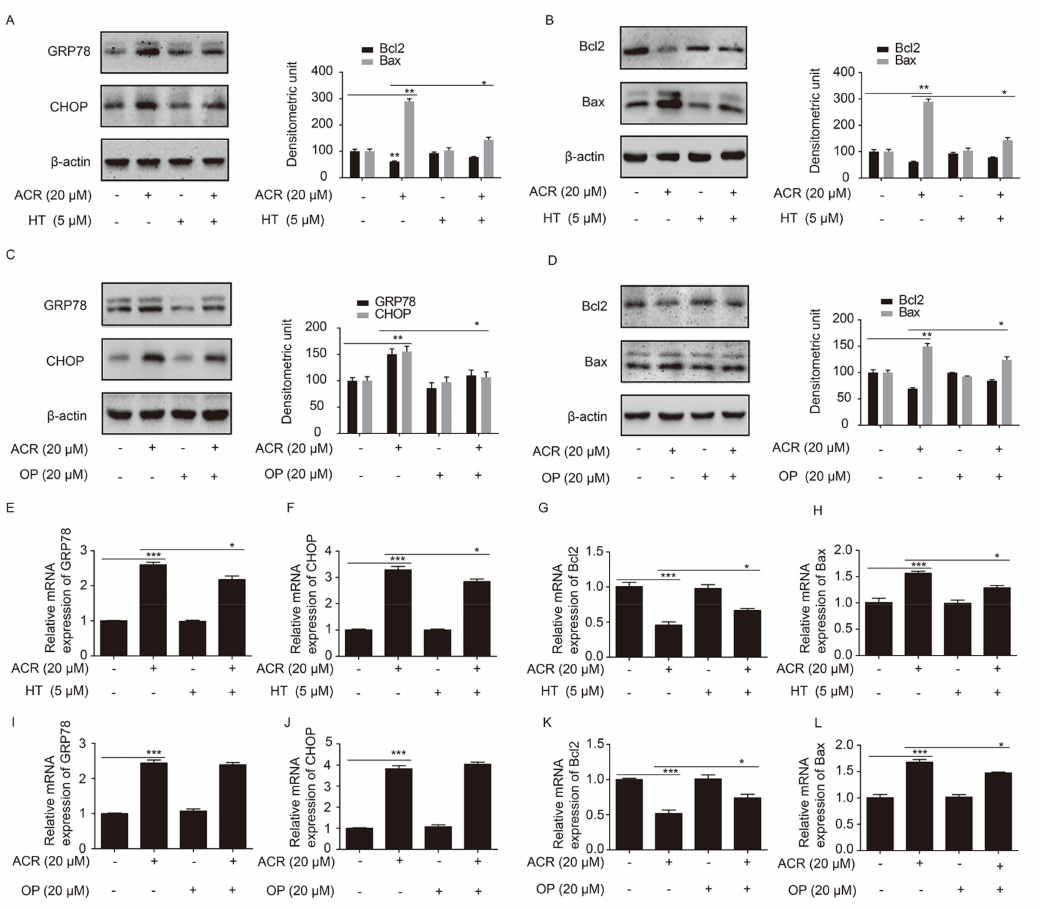
Figure 6. HT and OP attenuated the altered expression of GRP78, CHOP, Bcl2 and Bax induced by acrolein in H9c2 cells. ( A , B , E – H ) The expression of GRP78, CHOP, Bcl2 and Bax at the protein and mRNA levels after H9c2 cells were pretreated with HT (5 µ M) for 24 h, and the combination with acrolein (20 µ M) for 12 h, as measured by Western blotting and qRT-PCR. ( C , D , I – L ) The expression of GRP78, CHOP, Bcl2 and Bax at the protein and mRNA levels after H9c2 cells were pretreated with OP (20 µ M) for 24 h, and the combination with acrolein (20 µ M) for 12 h, as measured by Western blotting and qRT-PCR. * p < 0.05, ** p < 0.01 and *** p <